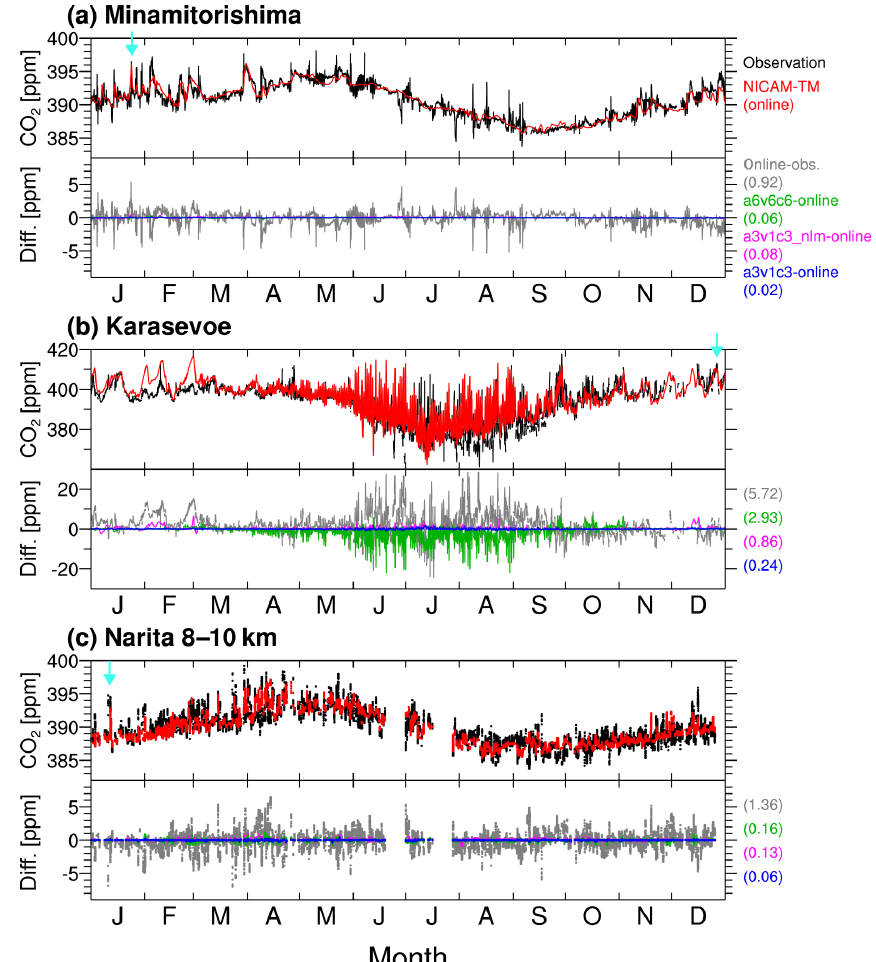
Figure 4. Time series of CO 2 concentration for 2010 at Minamitorishima (a) , Karasevoe (b) , and 8–10km altitude over Narita (c) . Each upper panel shows the time series observed (black) and simulated by the online model (red). Each lower panel shows differences of CO 2 concen- trations between the online model and the observation (gray), and between the offline model (green for A6V6C6, magenta for A3V1C3, and blue for A3V1C3 without the flux limiter) and the online model. The number in the parenthesis gives the RMSD value for each sensitivity case. Note that only tropospheric data (determined by the dynamical tropopause; Sawa et al., 2008) are used for the comparison over